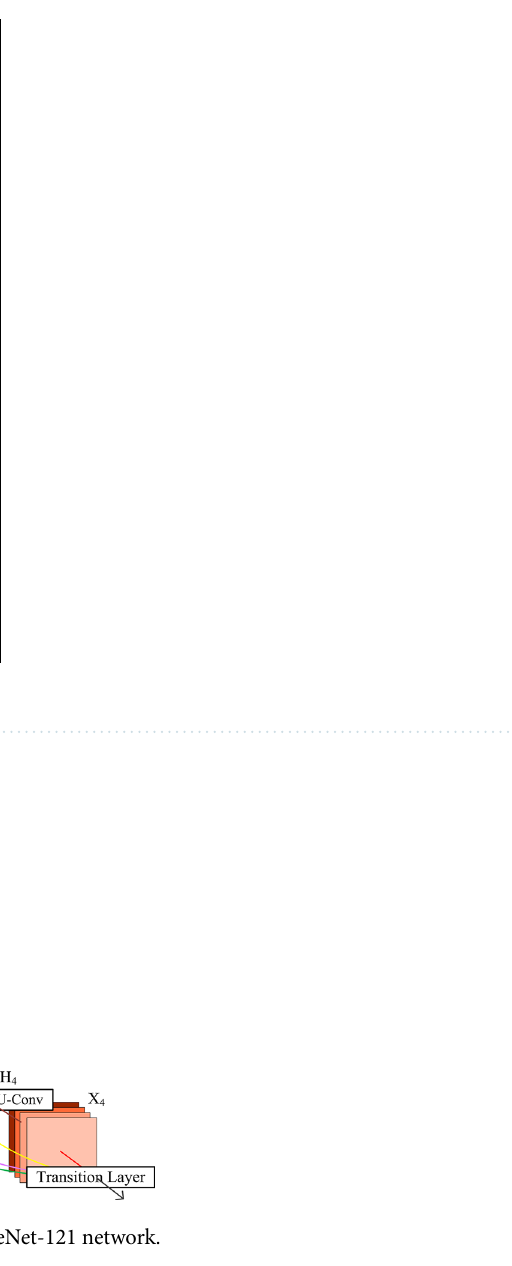
Table 3 outlines the configurations of the used VGGNets in this work. In the VGG network architectures, the input to the ConvNets is a fixed-size 256 × 256 thoracic image that passes through a stack of convolutional (conv.) layers with 3 × 3 filters used. The convolution stride is fixed to 1 pixel while the padding is 1 pixel for 3 × 3 conv. layers. Spatial pooling uses five max-pooling layers over a 2 × 2 pixel window with a stride of 2. Some conv. Layers are then followed. All hidden layers use the ReLU rectification non-linearity (except for the SPECS V7). The ReLU function is defined in Eq. (2).